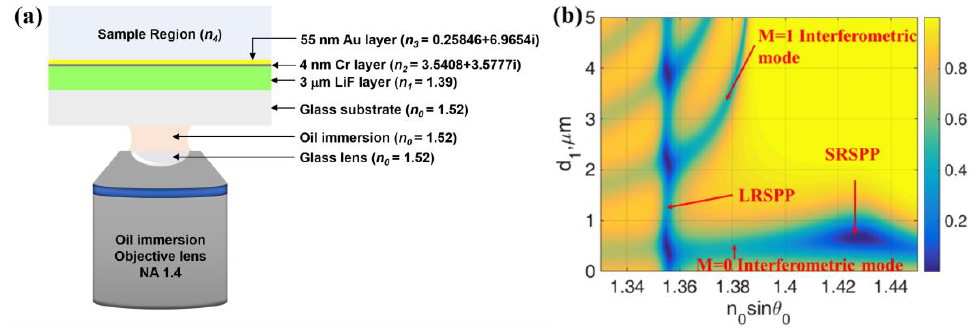
Figure 12. ( a ) The proposed self-reference SPR sensor ( b structure and) |r p | 2 responses when the sample refractive index n 4 was 1.33 calculated for 1.064 µ m incident wavelength.